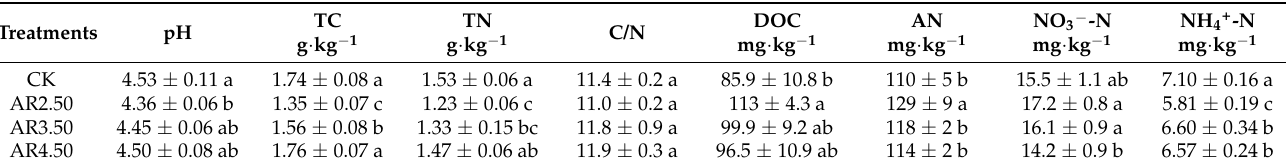
Table 1. Soil nutrient contents under different